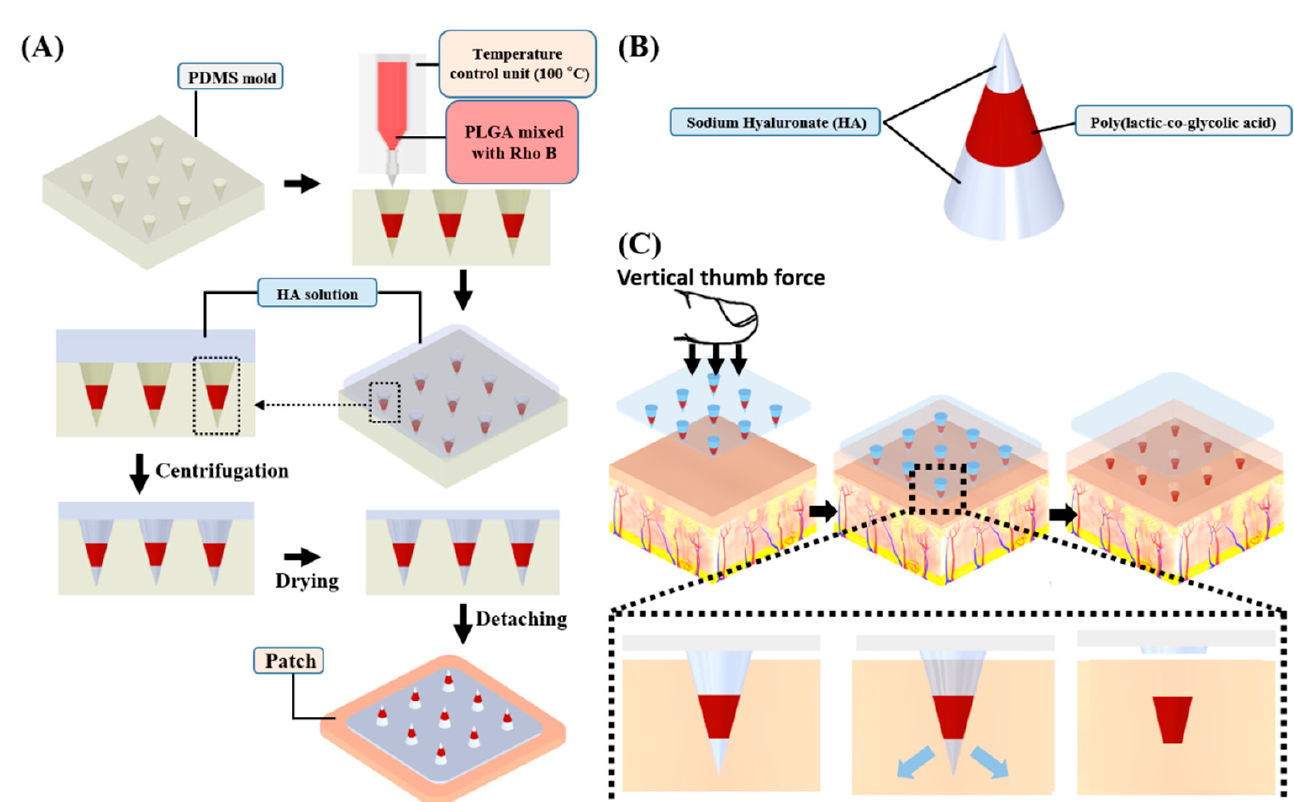
Figure 1. Schematic illustration of the fabrication process and application of an HMP-DMN patch. ( A ) Fabrication process using a PDMS mold. Heat-melted PLGA mixture loaded with rhodamine B was dispensed into the PDMS molds with the help of a dispenser robot and temperature control unit. Subsequently, the HA solution was cast into the PDMS mold, centrifuged, and dried. Finally, the HMP-DMN patch was detached from the PDMS mold. ( B ) Structure of an HMP-DMN. An HMP-DMN consists of three parts: HA—tip, PLGA mixture—middle, and HA—base layer. ( C ) Schematic representation of the application and separation of the HMP-DMNs from the patch. The HMP-DMN patch is inserted into the skin surface using vertical thumb force, following which the PLGA mixture separates from the patch upon dissolution of the HA base layer. The implanted PLGA mixture part then releases the drug inside the skin tissue in a sustained manner. (HMP-DMN: heat-melt PLGA dissolving microneedle, PDMS: polydimethylsiloxane, PLGA: poly(lactic-co-glycolic acid), HA: sodium hyaluronate).